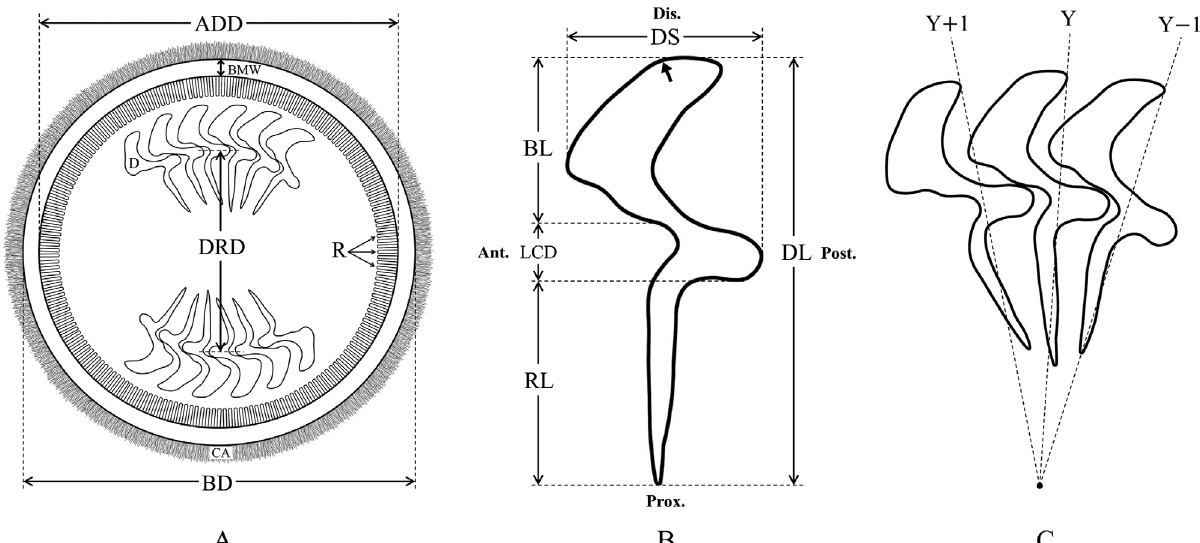
Figure 2. Measured and counted morphological characters of Trichodina unionis . (A) Morphological characters of the aboral side, (B) morphological characters of a denticle with the bold arrow indicating the distinctive bend angle on the blade margin, and (C) denticle arrangement. Abbreviations are as follows: Ant.: anterior side; ADD: adhesive disc diameter; BD: Body diameter; BMW: Border membrane width; CA: Cilia area; D: denticle; Dis.: Distal end; DRD: Denticular ring diameter, BL: Blade length; DL: Denticle length; DS: Denticle span; LCD: Length of central part of denticles; Post.: Posterior side; Prox.: Proximal end; R: Radial pin; RL: Ray 72 (cid:3) C. Gel electrophoresis was used to observe the presence of DNA samples were puri fi ed and sequenced by Macogen, Korea, PCR products of the correct size in 1.5% agarose gel stained using the same forward and reverse primers that were used for with SYBR safe (Invitrogen) at 50 V for 60 min. The ampli fi ed the PCR.